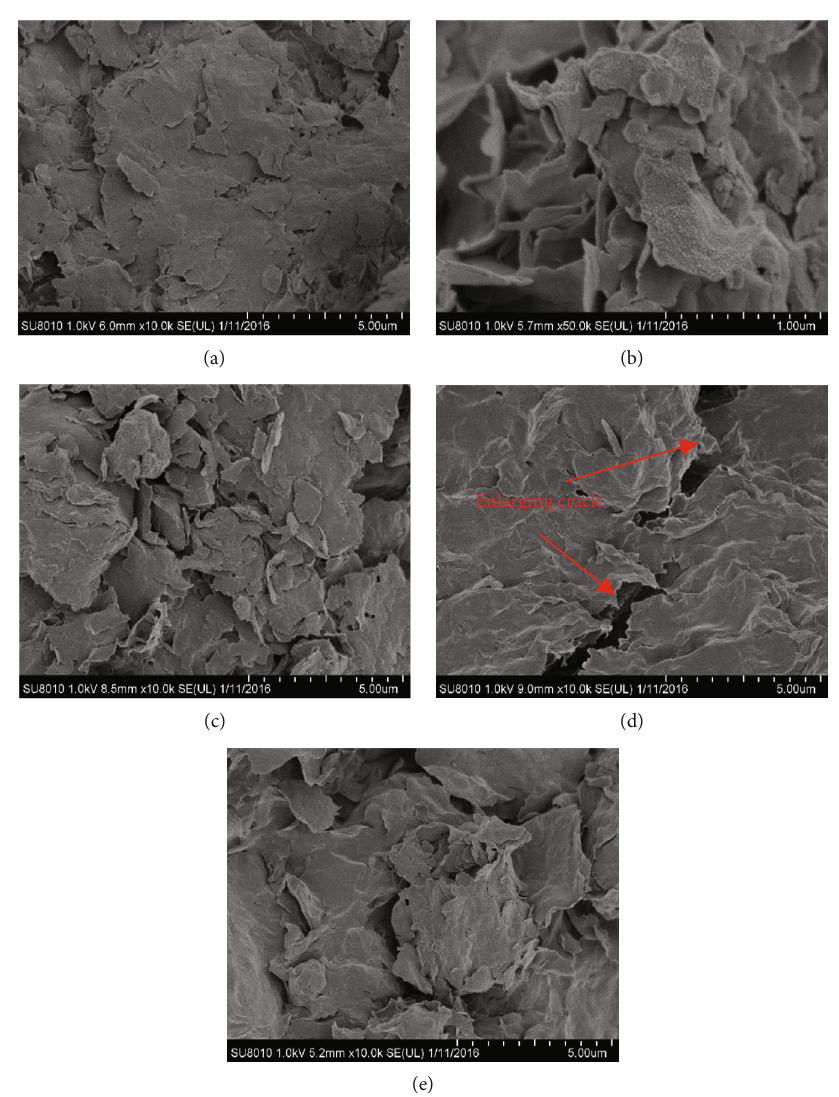
Figure 6: SEM pictures of rock samples under di ff erent water contents ((a) dry state, (b) 7% water content, (c) 8% water content, (d) 9% water content, and (e) 10% water content (saturated